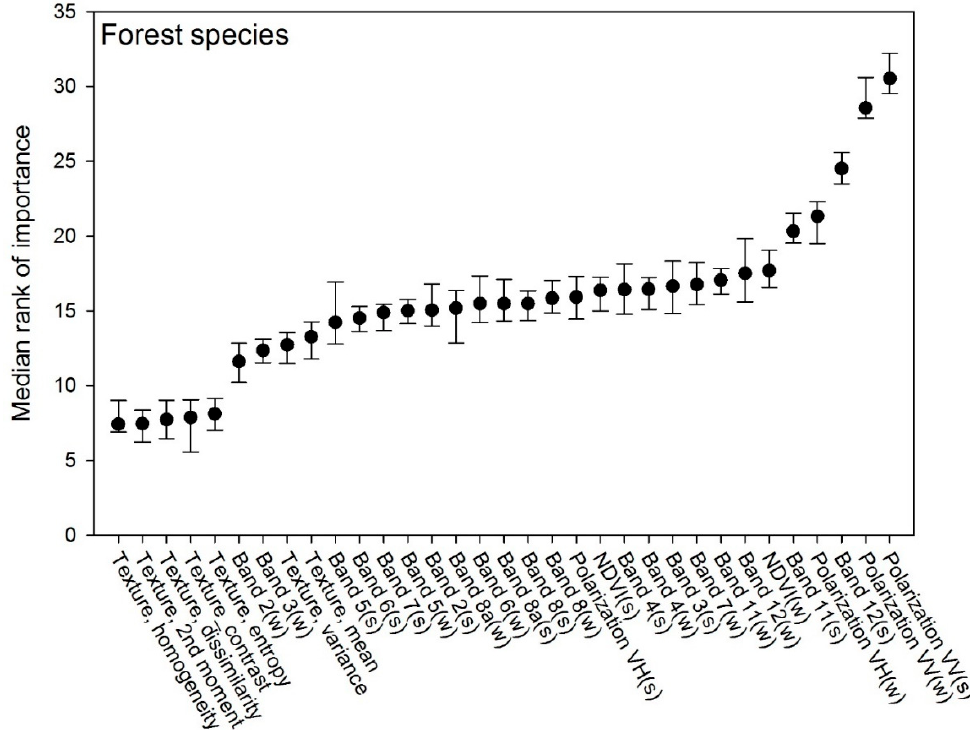
Figure 4. Input features for predicting tree species ranked after importance by the Boruta simulations. Table 4. Confusion matrix and producer (PA), user (UA), and overall (OA) accuracy statistics of the tree species classification based on the independent evaluation reference data. Entries in the matrix represent the number of pixels. Forest area distribution to forest tree species and the